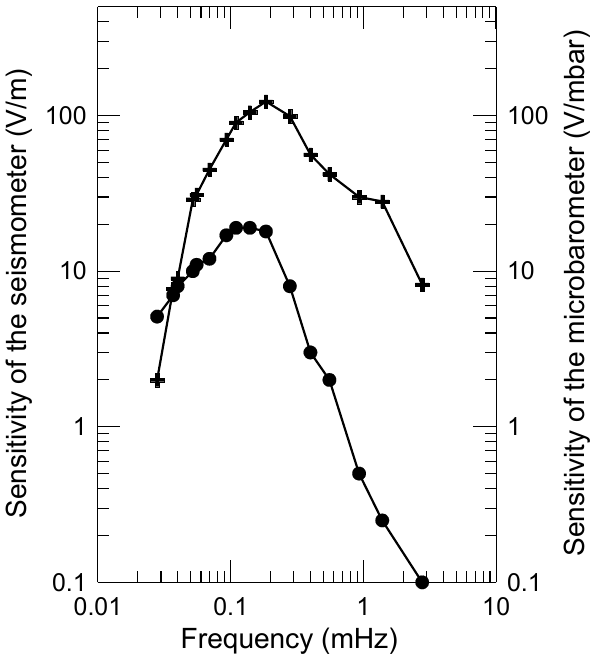
Fig. 1. Fig. 1. Amplitude-frequency responses of microbarometer (circles) and seismometer